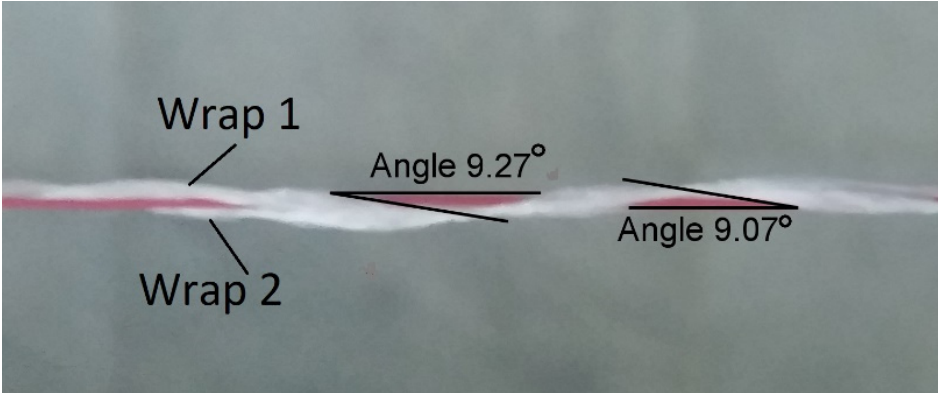
Figure 1. Measured angles of twists for both the wraps with PU core.